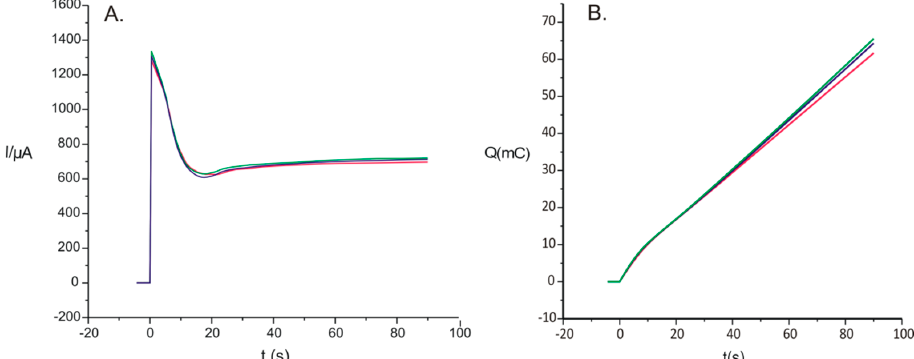
Figure 3. ( A ) Dependence of current (I) versus time (t) of curves registered in the electrosynthesis process of PPy /FeCN films at 0.8 V for 90 s. ( B ) Charge (Q) versus time (t) when PPy underwent electrosynthesis in the presence of FeCN for three replicate sensors.